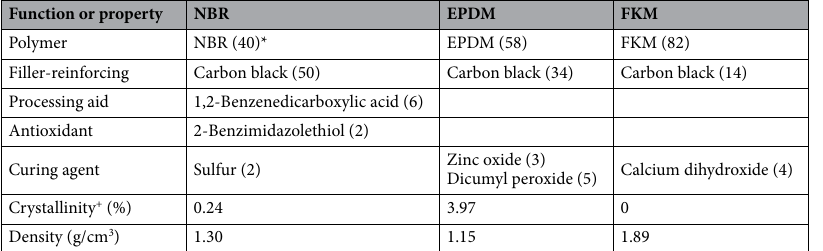
Table 1. Chemical compositions (according to function) and related properties of NBR, EPDM and FKM specimens. *Numbers in ( ) are weight ratios in %. + Degree of crystallinity (%) can be determined from area of melting peak by differential scanning calorimeter (DSC) 35 .